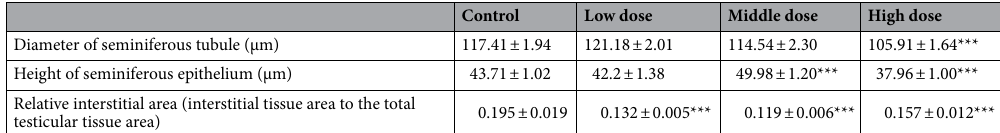
Table 4. Testicular morphology of CORT-administered in mice on PND 16. Values are expressed as the mean ± S.E.M. of data from 10 animals per group (10 seminiferous tubules or pictures per animal). ***p < 0.001 versus the control group. CORT